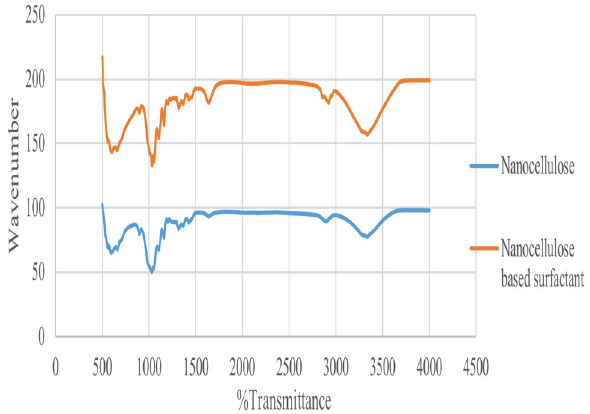
Fig. 2 FTIR of nanocellulose and nanocellulose-based